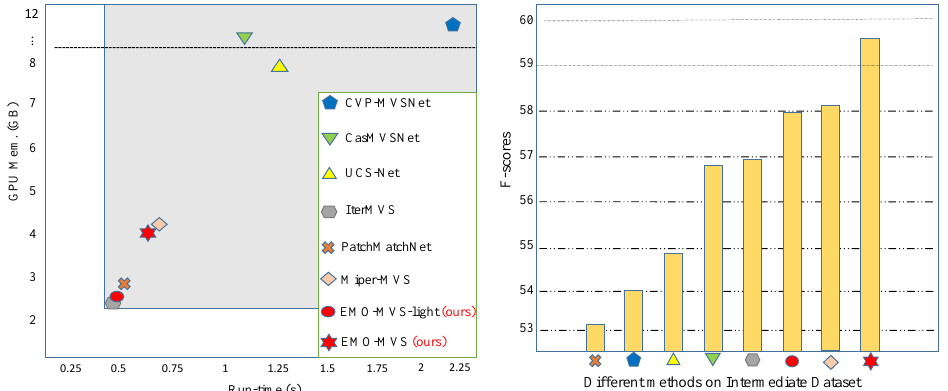
Figure 2. Comparison with the state-of-the-art learning-based MVS methods on Tanks and Temples. The left graph shows the GPU memory and run-time of various methods (image size 1920 × 1024, 7 views). The right graph is the comparison of the F-score ( ↑ ). Where EMO-MVS-light is the version without Error-Aware enhancement, EMO-MVS is our full version, our approach has the best balance between computational costs and